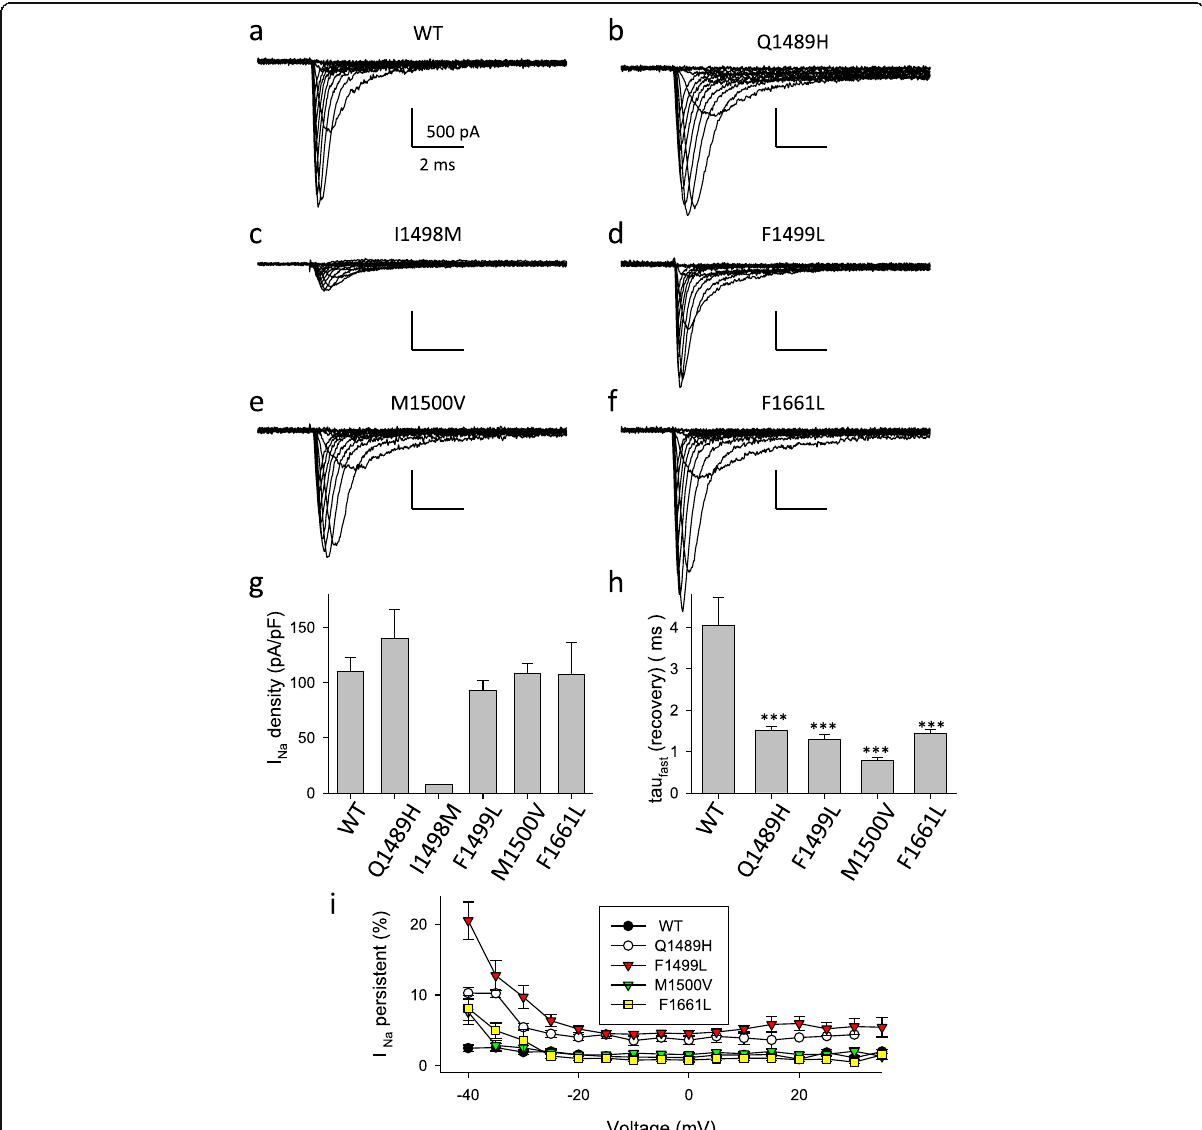
Fig. 2 Electrophysiological analysis of 5 FHM3 mutations in HEK cells. a - f show typical voltage clamp current traces in response to the standard IV protocol. Scale bars: 2 ms and 500 pA, respectively. g shows the peak current density and h the time constant of recovery from inactivation at − 90 mV. i show the relative persistent current. Values for mutants F1499L and Q1489H are significantly larger than those of WT ( p < 0.001) at all voltages. Values for mutants F1661L and M1500 V are statistically significantly different from those of WT only at − 40 mV ( p <